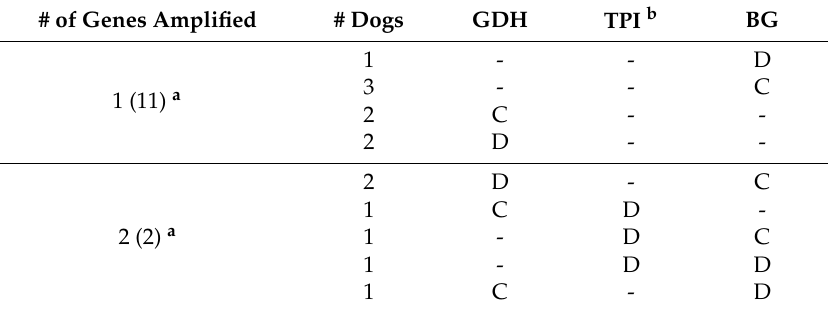
Table 2. Giardia duodenalis assemblages in dogs in Pine Ridge Reservation, South Dakota by GDH, TPI, and BG